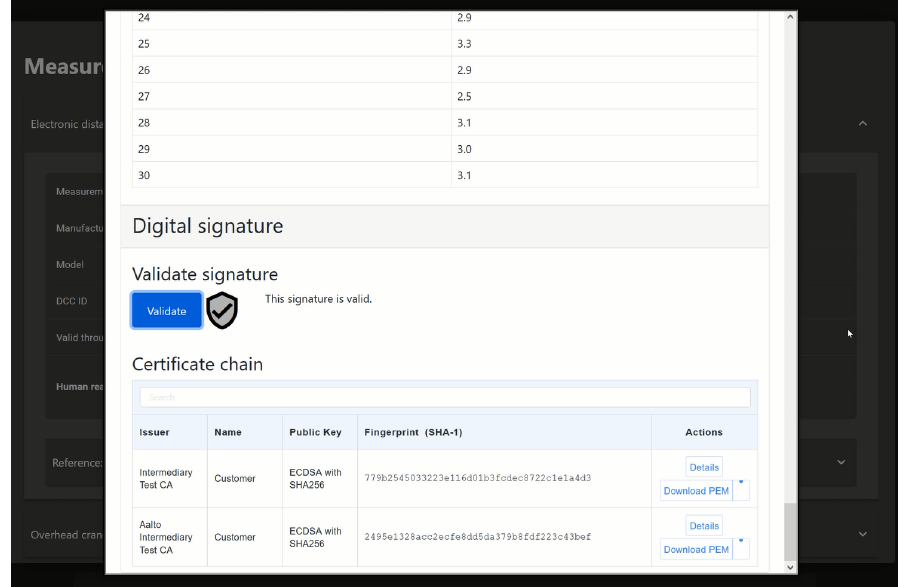
Figure 6. The UI showing that the digital signature of a DCC is valid. Below the validation tool is information about the public keys of the authority that created the signature and the issuer of that public